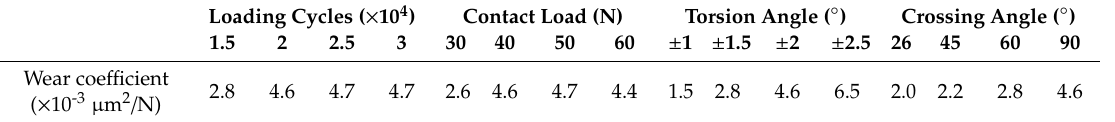
Table 9. Coe ffi cients of cyclic wear at di ff erent fretting and torsional